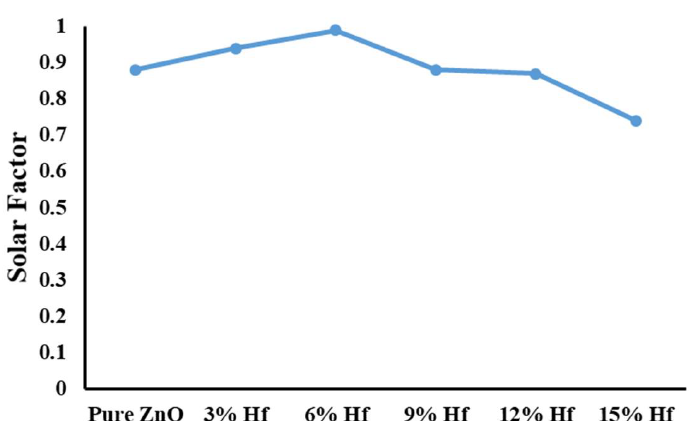
Figure 5. Solar factor for self-cleaning glazing based on different Hf-doped ZnO.